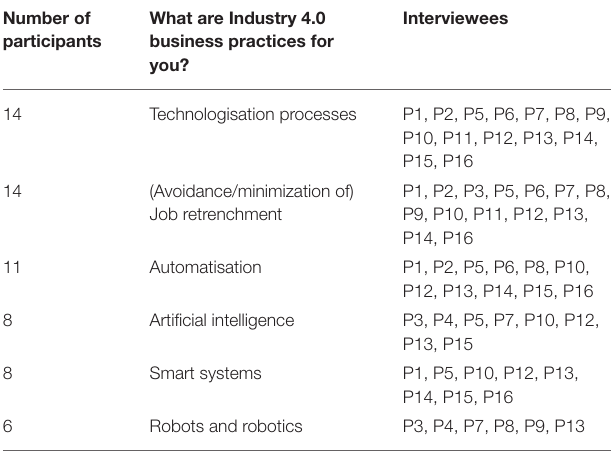
TABLE 1 | Sustainable Industry 4.0 business